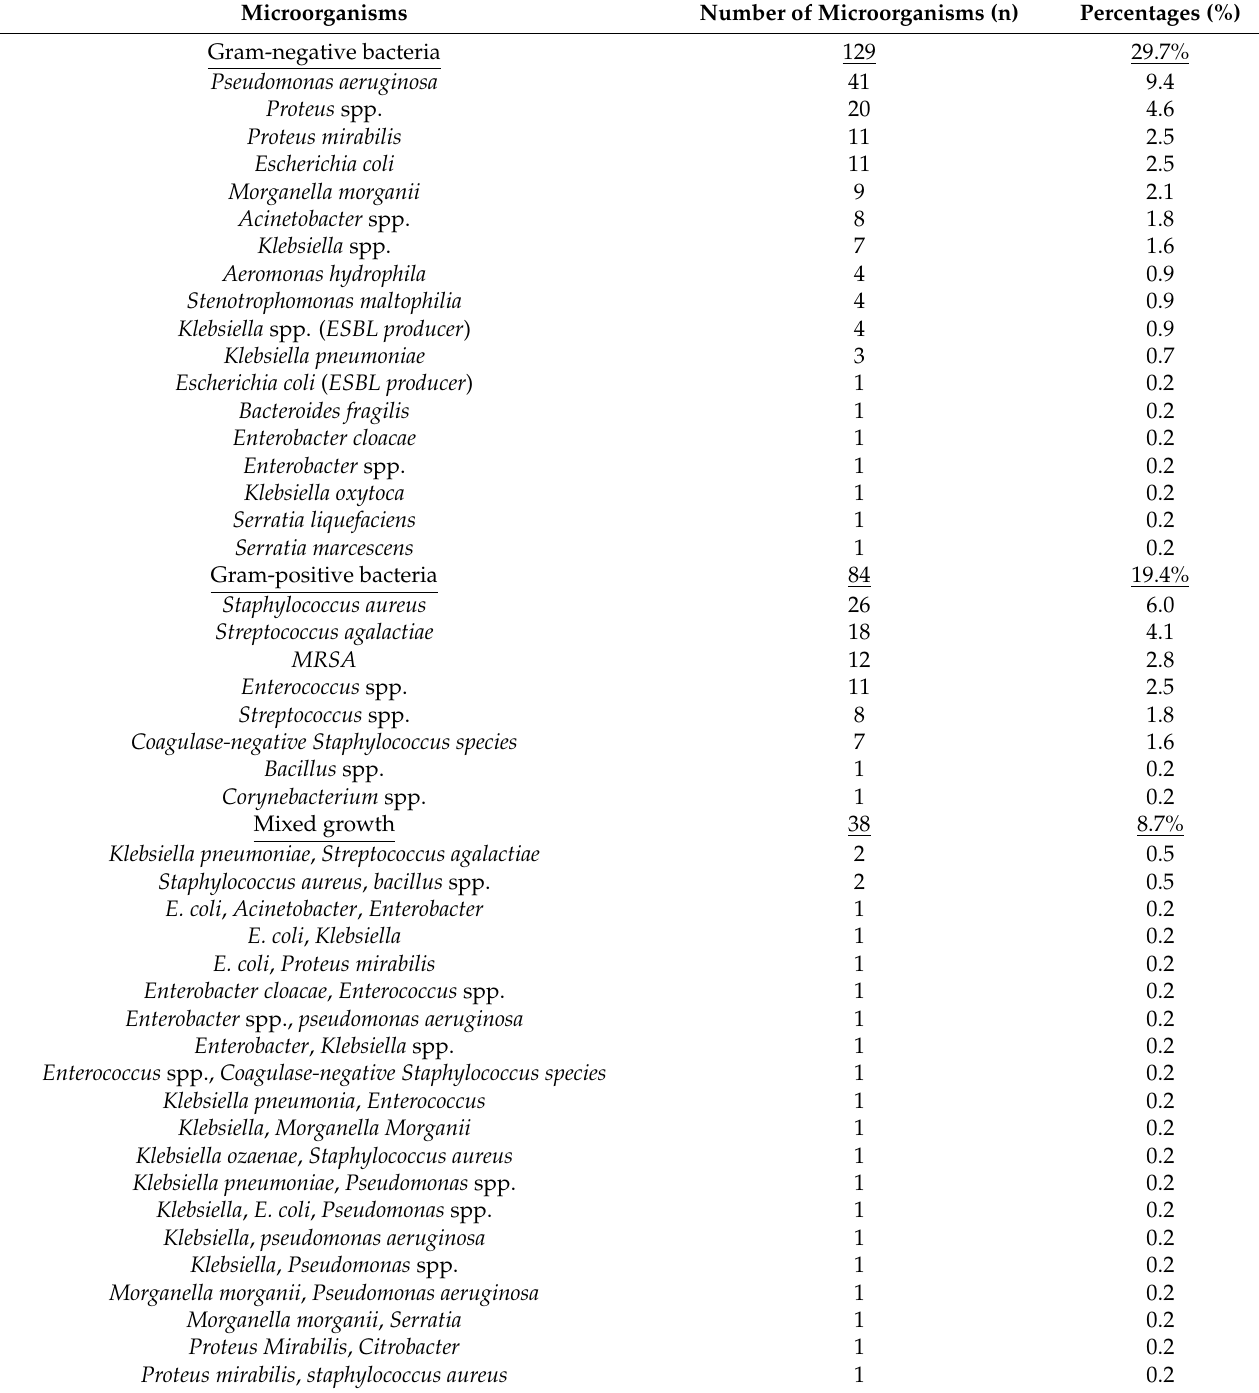
Table 5 illustrates the distribution of Gram-positive and Gram-negative bacteria among DFI patients. The Gram-negative bacteria were determined in 129 (29.7%) DFI patients, and, on the other hand, 84 (19.4%) patients were diagnosed with infections by Gram-positive bacteria. Interestingly, mixed growth infection had a substantial rate among DFI patients, with 80 (18.4%). The data show that Pseudomonas aeruginosa (9.4%) was the most common causative Gram-negative microorganism, followed by Proteus spp. (4.6%), Proteus mirabilis (2.5%), and Escherichia coli (2.5%). Table 5. Distribution of Gram-positive and Gram-negative